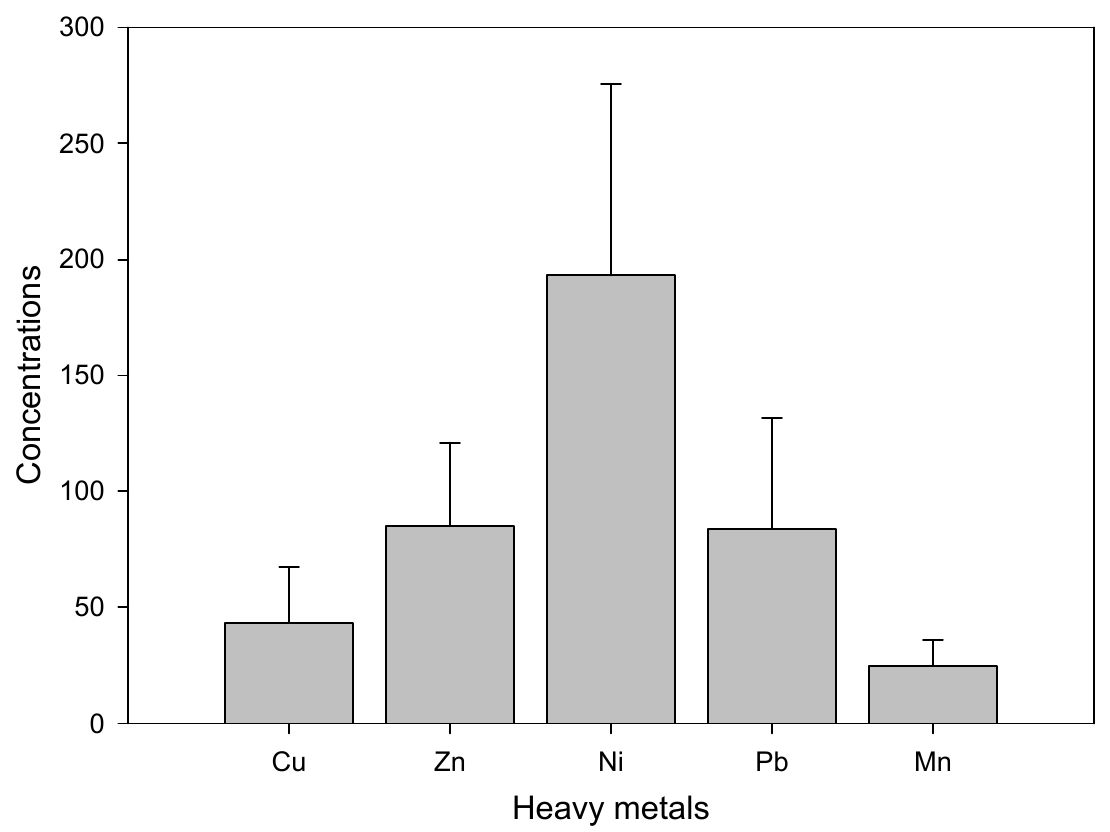
Figure 2. Mean heavy metals concentration (mg/kg) in soil samples.